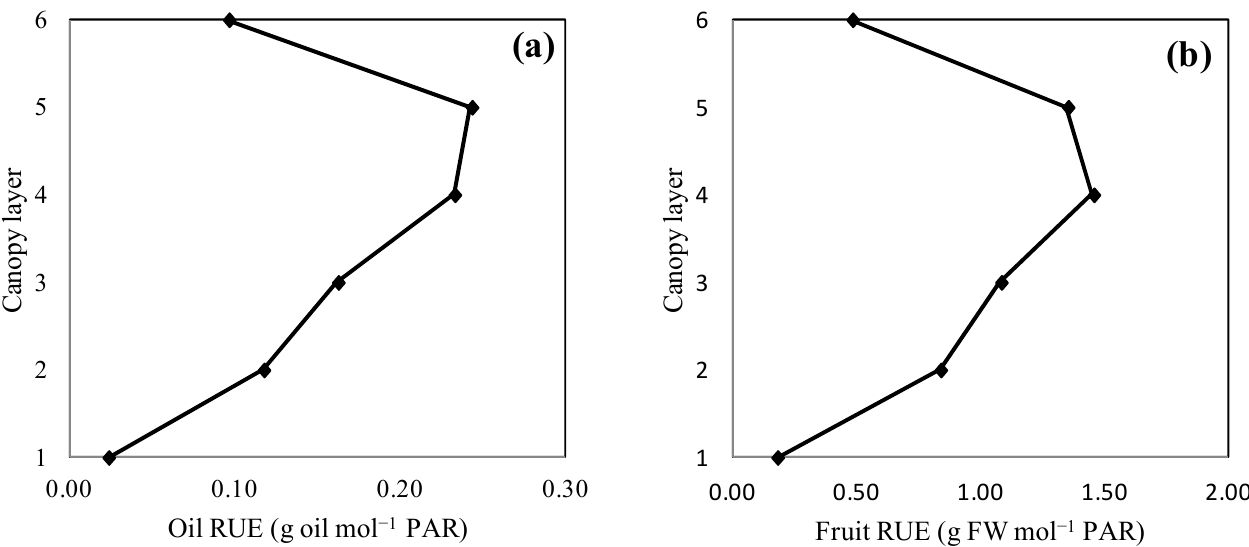
Figure 7. Variation of ( a ) Oil radiation use efficiency (RUE) and ( b ) Fruit RUE in the canopy profile, from the top (i.e., layer 6) to the bottom (layer 1) of the canopy. Both Oil and Fruit RUE were calculated from data on fruit density, fruit weight and oil content, and data on PAR interception over the fruiting period for individual layers, reported in Trentacoste et al. [28].